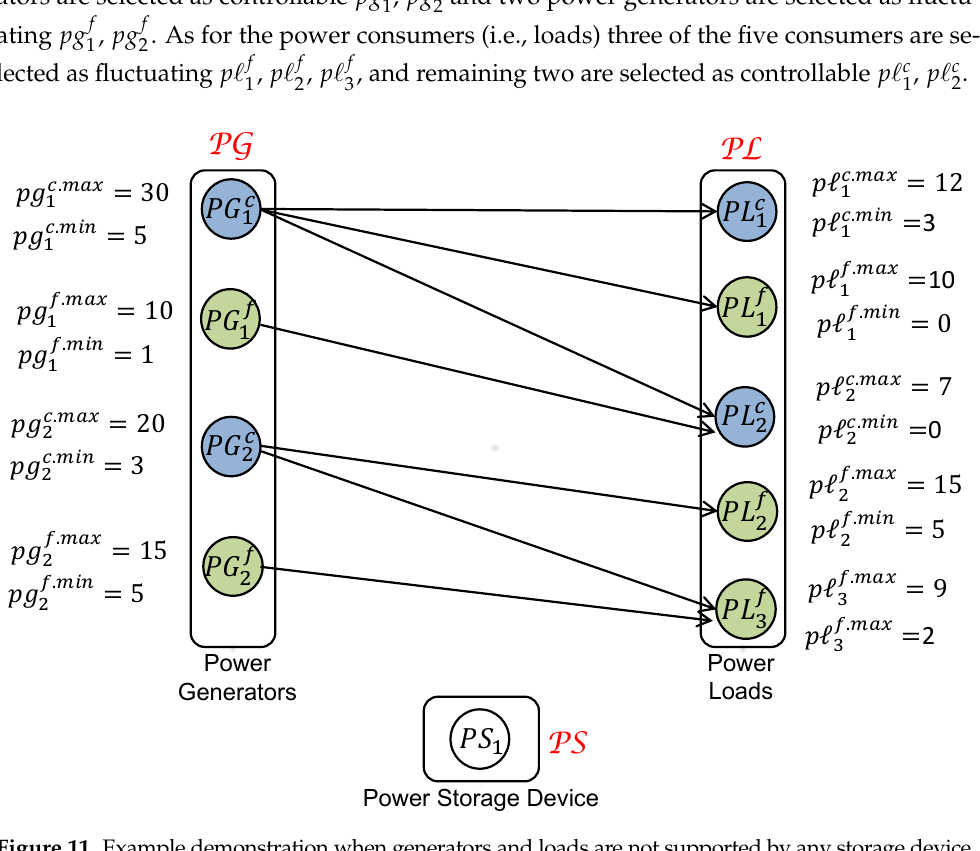
power generators and loads are set as given in Figure